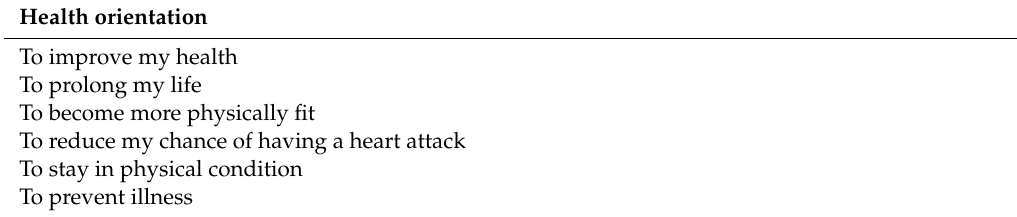
Table A1. MOMS–MOTIVATIONS OF MARATHONERS SCALE (Possible reasons to